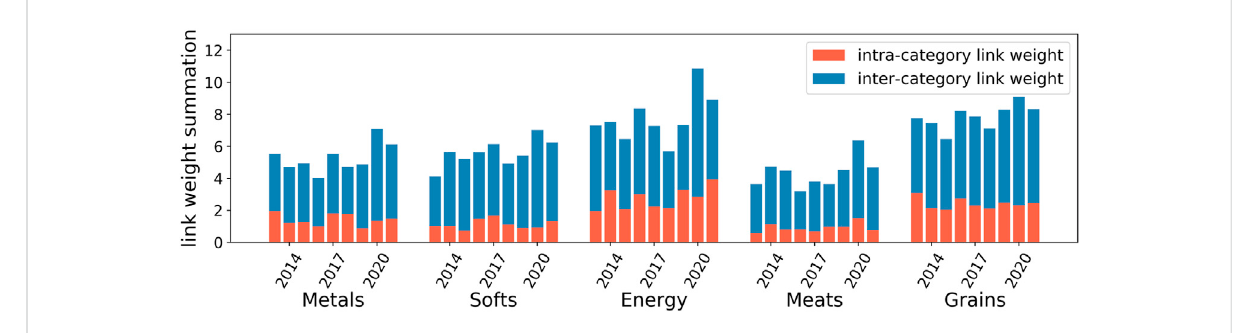
FIGURE 4 Stacked bar plot for yearly weight summation of intra- and inter-category